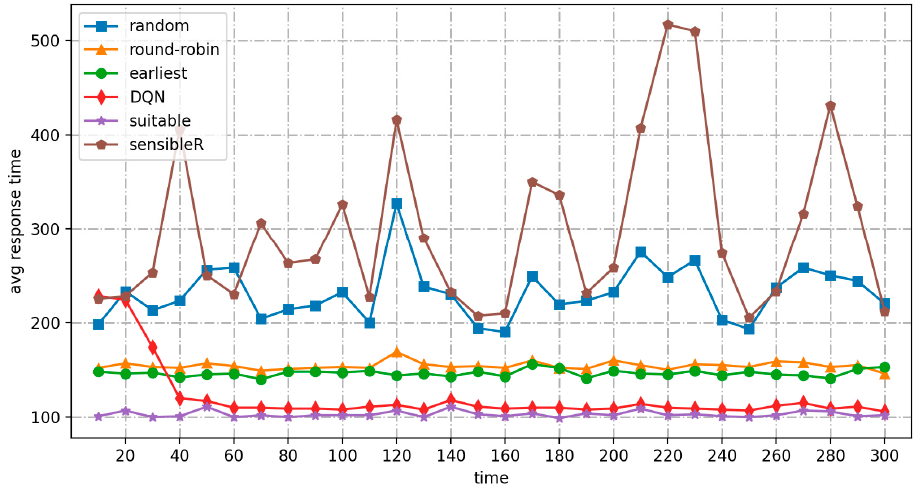
Figure 8. Job arrival rate in low-frequency workload mode.